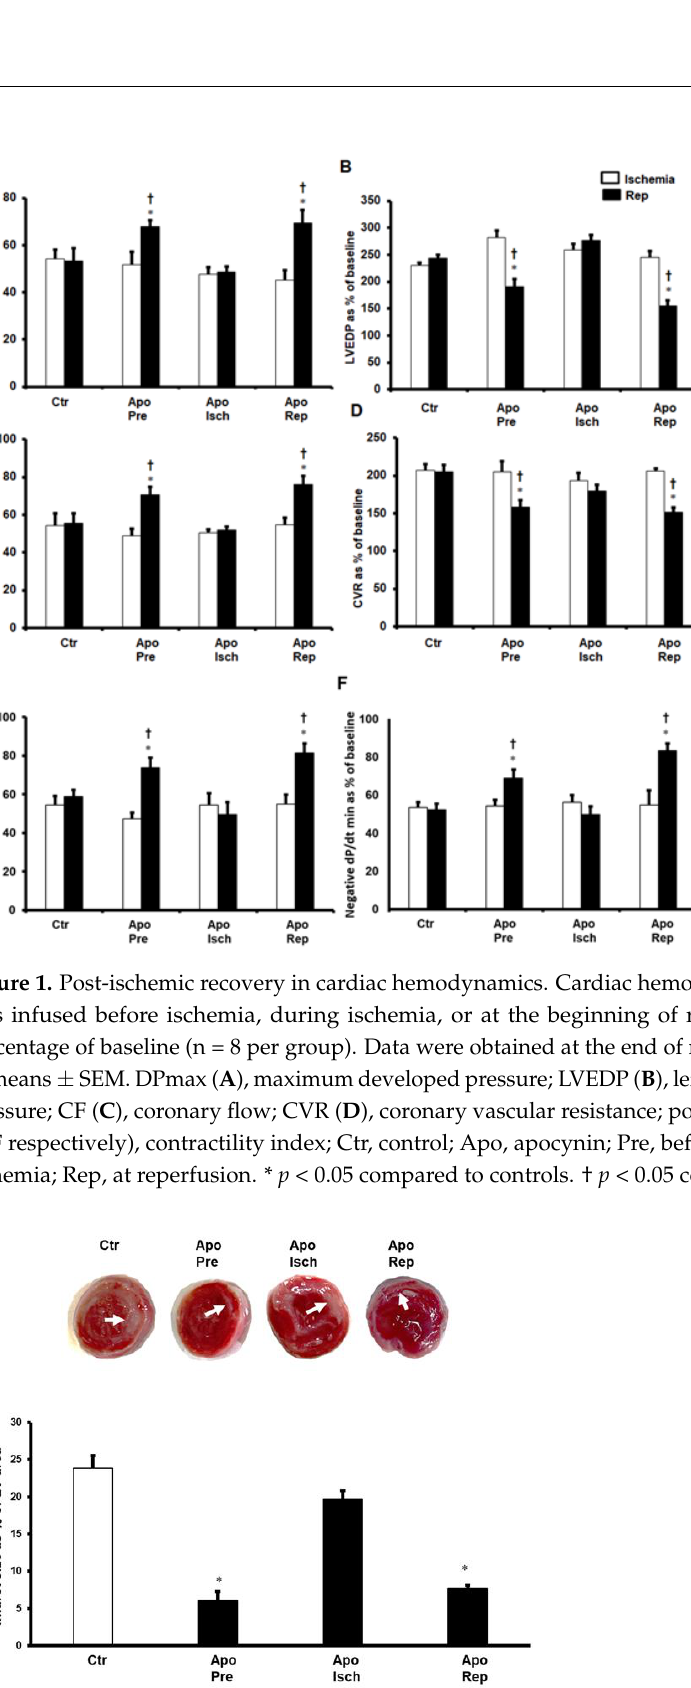
Figure 2. Infarct size presented as percentage of LV area. Evaluation of infarct size when apocynin was infused before ischemia, during ischemia, and at the beginning of reperfusion (n = 4 per group). Data are shown as means ± SEM. Ctr, control; Apo, apocynin; Pre, before ischemia; Isch, during ischemia; Rep, at reperfusion. ( A ) shows the TTC staining for the evaluation of the infarct size, and ( B ) shows the infarct size as percentage of LV area. * p < 0.05 compared to controls. To understand the possible inducers of apocynin’s protection of the heart from I/R injury, the involvement of NO in this protection was evaluated. The nitric oxide donor SNAP was used in this study in combination with apocynin. However, this did not result in a synergetic addition to the protection of the heart given by apocynin, and an infusion of SNAP did not block apocynin from protecting the heart. DPmax and LVEDP were sig- nificantly improved compared to ischemic periods and untreated controls (Figure 3A,B). Similarly, infusion of SNAP in combination with apocynin significantly ( p < 0.05) in- creased CF and decreased CVR when compared to ischemic periods and untreated con- trols (Figure 3C,D). Infusion of the nitric oxide donor (NO) S-nitroso-N-acetylpenicilla- mine (SNAP) also significantly ( p < 0.05) improved ±dP/dt compared to ischemic periods and untreated controls (Figure 3E,F). To validate the effect of NO on apocynin’s protection of the heart, the NO blocker L-Name was used in combination with apocynin. This treat- ment negated apocynin’s protection of the heart from I/R (Figure 3A,F). The transmembrane protein CD38 exerts a major role in calcium signaling. In this study, 78c, the blocker of CD38, completely abrogated apocynin’s protection of the heart (Figure 3A–F). To further illustrate the role of CD38 in the protection of the heart by apocynin cADPR, a potent messenger for calcium release from the sarcoplasmic reticulum (SR) was used. The infusion of cADPR in combination with apocynin negated the protec- tive effects of apocynin when given alone compared to ischemic periods and untreated controls (Figure 3A–F). The lack of protection of the heart by cADPR highlighted a possible protective role for the other downstream effector of CD3 (NAADP). Therefore, Ned-K, a potent inhibitor of NAADP, was infused in combination with apocynin to evaluate the effect of NAADP on the apocynin’s protection of the heart from I/R injury. Interestingly, infusion of the NAADP inhibitor blocked the protective effects that were obtained from infusing apocynin alone (Figure 3A–F).